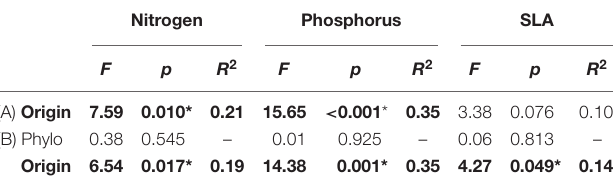
R 2 indicates variance explained out of the total variance of the data. Significant values (p ≤ 0.05) are in bold. Values marked with * are significant even after sequential Bonferroni